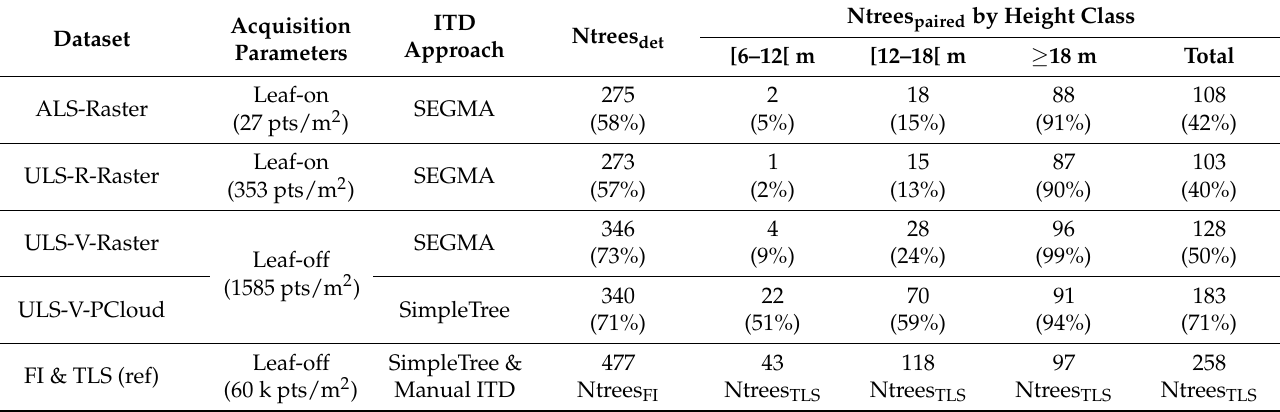
Table 4. Detailed ITD performance that was obtained from each aerial dataset with their main acquisition parameters and the ITD algorithm that was applied. Ntrees det represents the total number of trees that detected over the stand among the N = 477 trees that were measured in the field inventory (Ntrees FI ). Ntrees paired represents the number of Ntrees det that formed matched pairs with the N = 258 TLS reference trees (Ntrees TLS ) and are presented by height